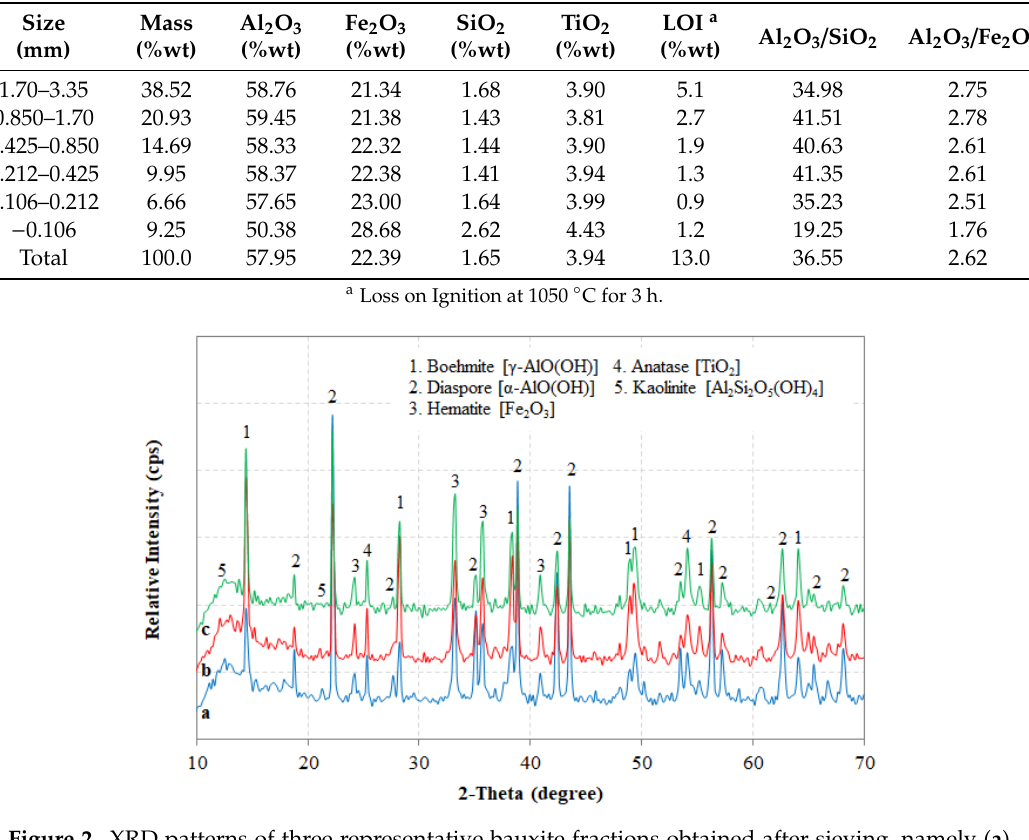
Figure 2. XRD patterns of three representative bauxite fractions obtained after sieving, namely ( a ) 1.70–3.35 mm fraction, ( b ) 0.212–0.425 mm fraction, and ( c ) − 0.106 mm fraction.